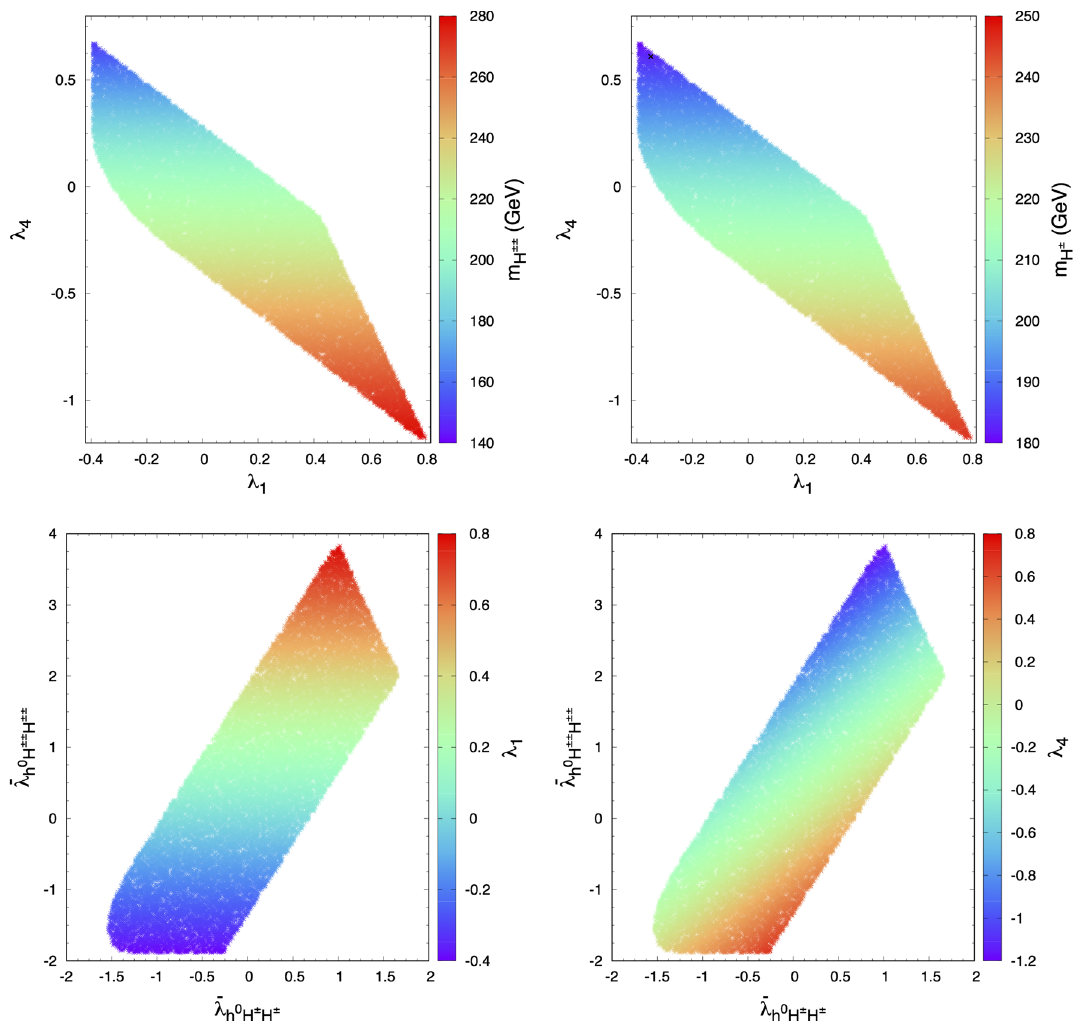
ing the sign of λ 1 (left) and λ 4 (right). Input parameters are λ = 0 . 517 ( m h 0 = 125 . 09 GeV), λ 3 = 2 λ 2 = 0 . 2, v Δ = μ = 1